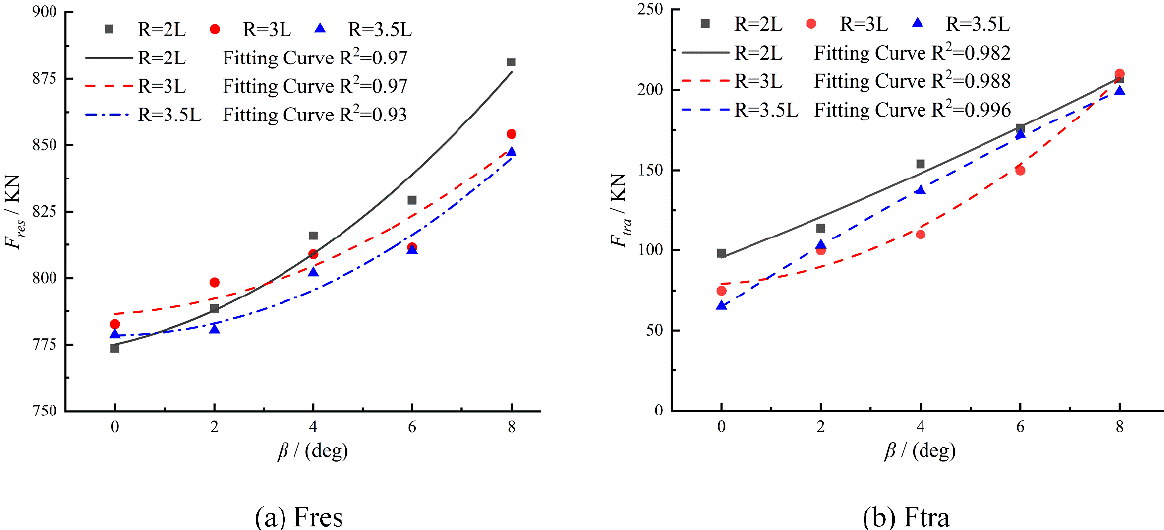
Figure 19. Average ice resistance and transverse force curves under different drift angles.